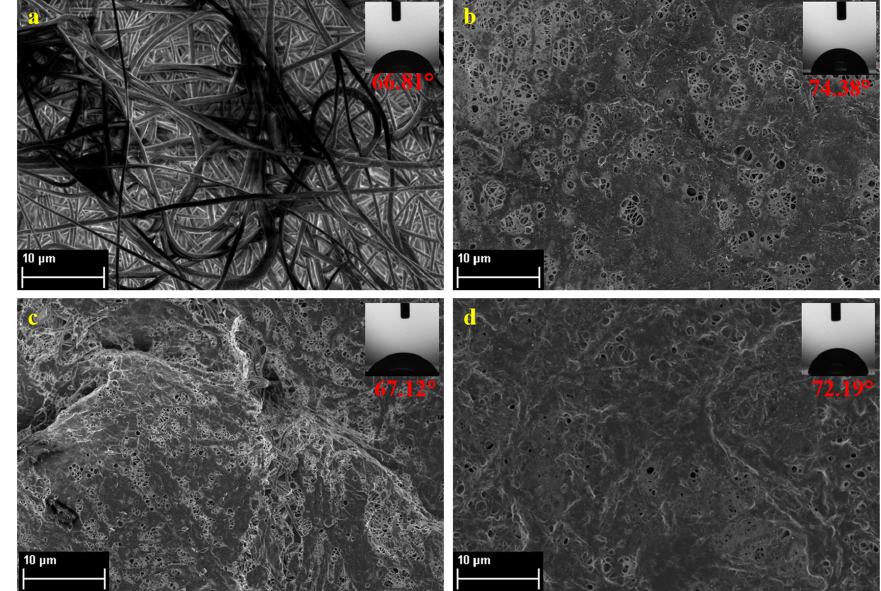
Figure 3. The surface morphology of the membranes shown by FESEM imaging for each electrolyte